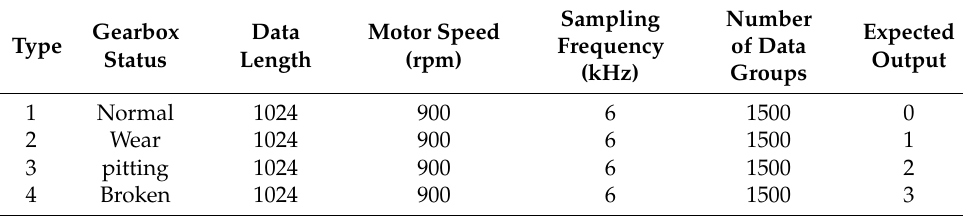
Table 1. Gearbox experimental data information.